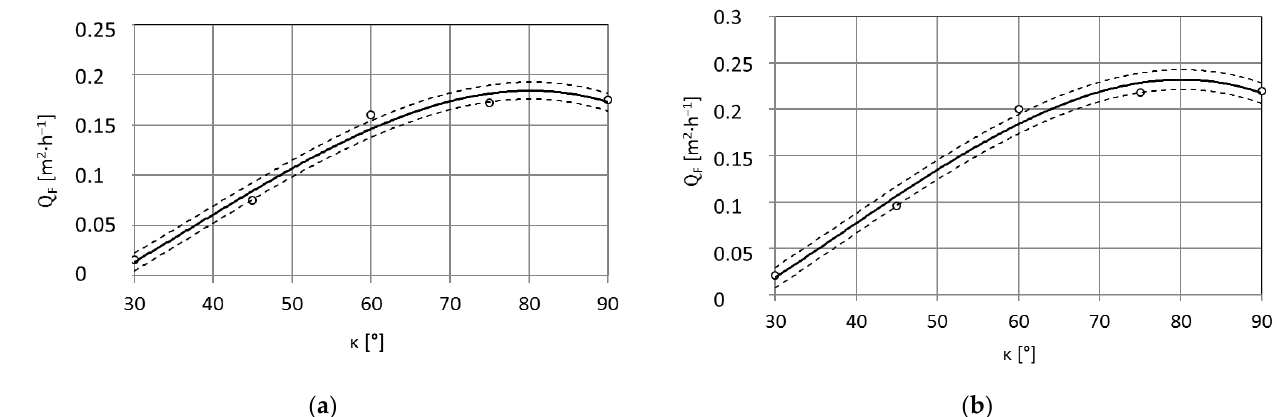
Figure 15. Impact of spray angle κ [ ◦ ] on maximum surface efficiency Q F [m 2 · h − 1 ] of high-pressure water-ice jet paint coat stripping from PA2 aluminium alloy surface (TS = 4 × 1.2 mm, L k = 200 mm, l 2 = 250 mm, m L = 156 kg · h − 1 ): ( a ) Jet pressure p w = 20 MPa; ( b ) p w = 35 MPa.